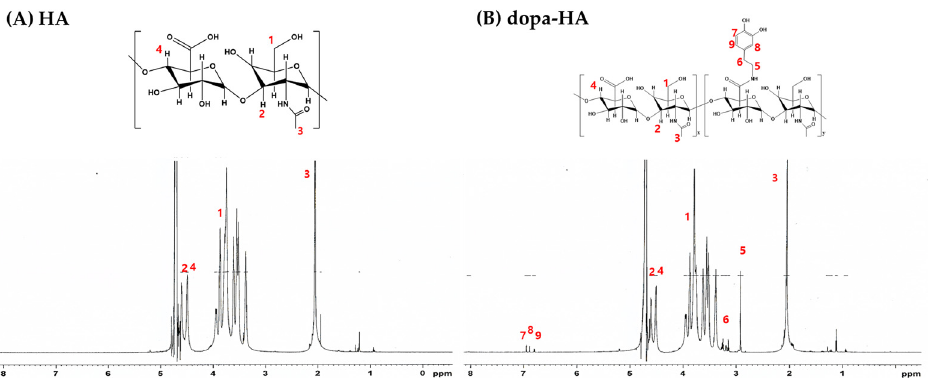
Figure 1. 1 H-NMR spectra of ( A ) HA and ( B ) dopa-HA.